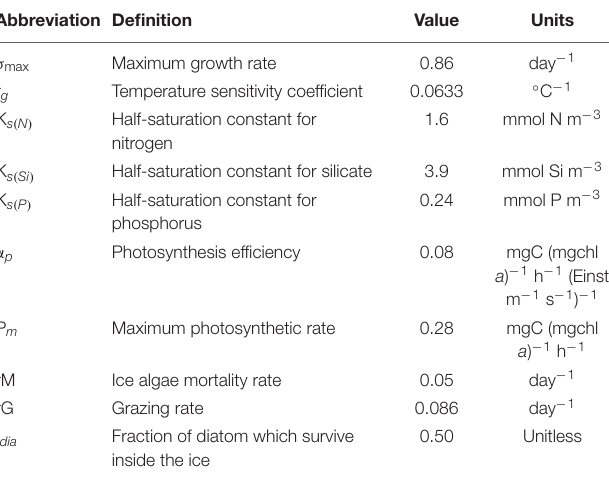
TABLE 1 | List of parameters, corresponding description, and units used in the model for ice algae